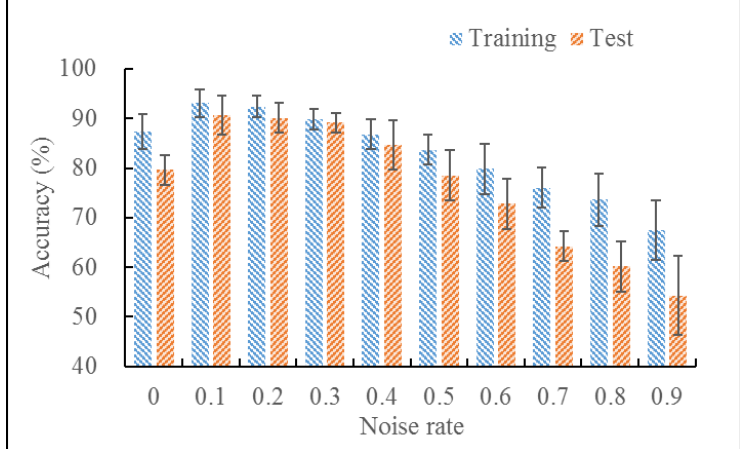
Figure 12. Recognition rate under different noise rates.